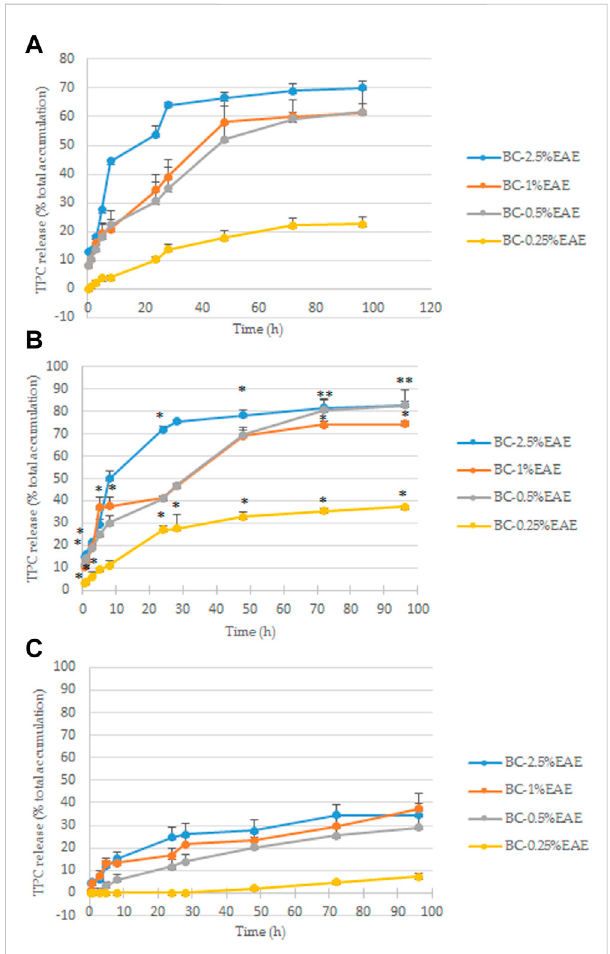
FIGURE 6 The total polyphenol content released from BC at 37 ° C in PBS, determined according to the modi fi ed Taokaew method (Taokaew et al., 2014) (A) and the Cacicedo method (Cacicedo et al., 2016) (B) ; statistical differences between these two method were determined by Student ’ s t-test and presented as * p < 0.05. The total polyphenol content released from BC at 37 ° C in the cell culture medium was determined according to the modi fi ed modi fi ed Cacicedo et al., 2016 (C) . The differences between these two fl uids (PBS and medium, Fig. B and C) determined by Student ’ s t-test, were signi fi cantateachpointbutforthesakeofclarityarenotshownonthe chart. All fi ndings are presented as a percentage of total polyphenol content accumulated in BCs (Table 1).